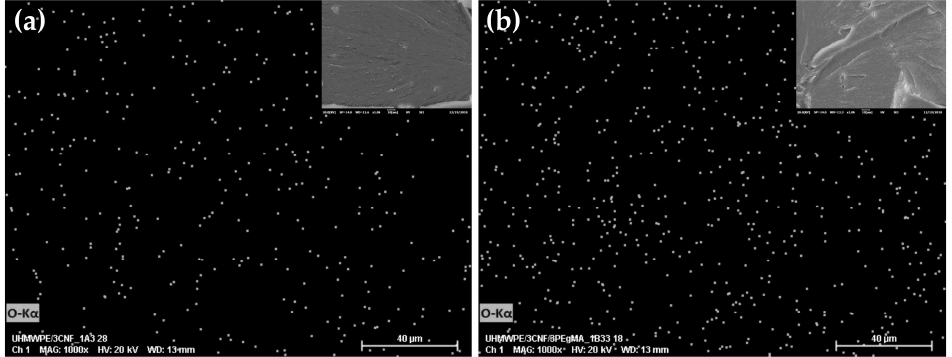
Figure 9. SEM-EDSimagesof( a )uncompatibilizedand( b )MAPE(maleicanhydride-grafted-polyethylene)- Figure 9. SEM-EDS images of ( a ) uncompatibilized and ( b ) MAPE (maleic anhydride-grafted- compatibilized UHMWPE / CNF polyethylene)-compatibilized UHMWPE/CNF bionanocomposites.